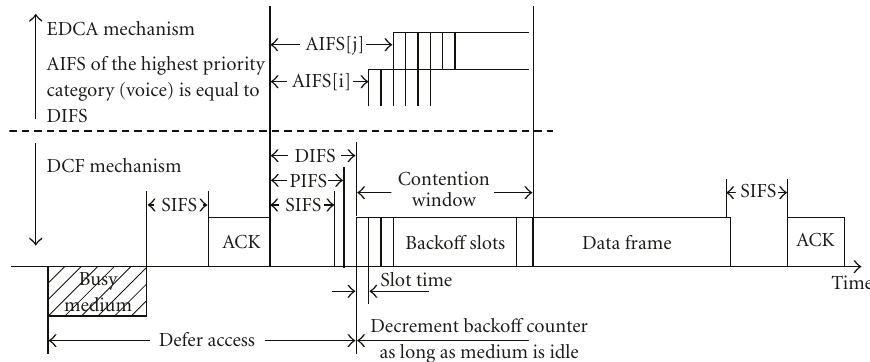
Figure 1: Interframe spaces in the DCF and EDCA